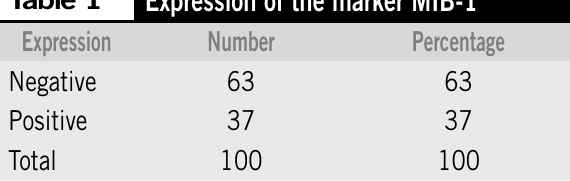
expression of the marker MiB-1